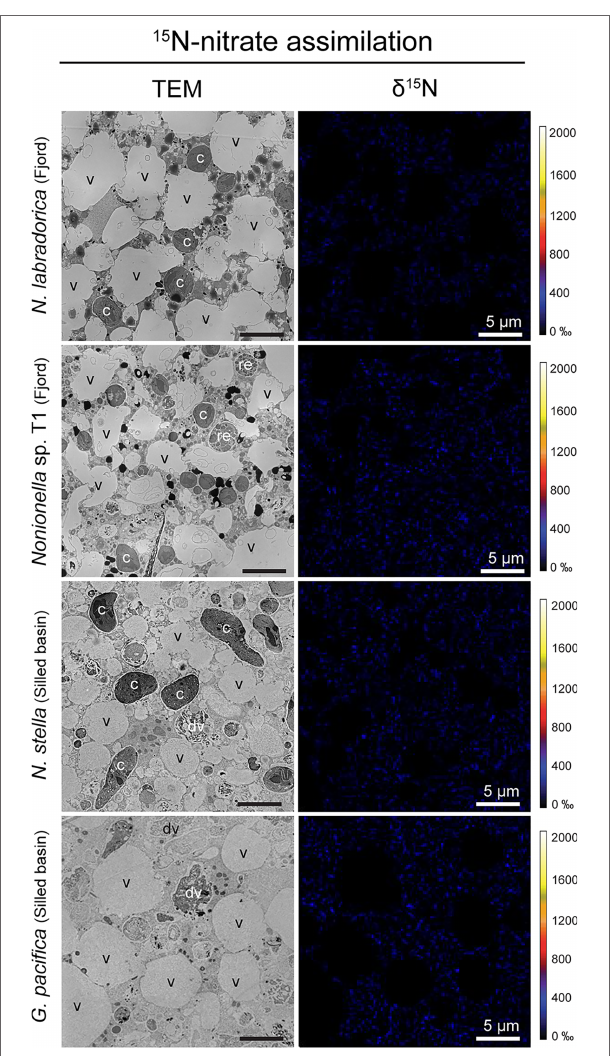
FIGURE 3 | TEM micrographs of different benthic foraminiferal species’ cytoplasm and corresponding NanoSIMS images of 15 N-nitrate assimilation (expressed as δ 15 N in ‰). c, kleptoplasts; dv, degradation vacuoles; re, residual bodies; v, vacuoles.